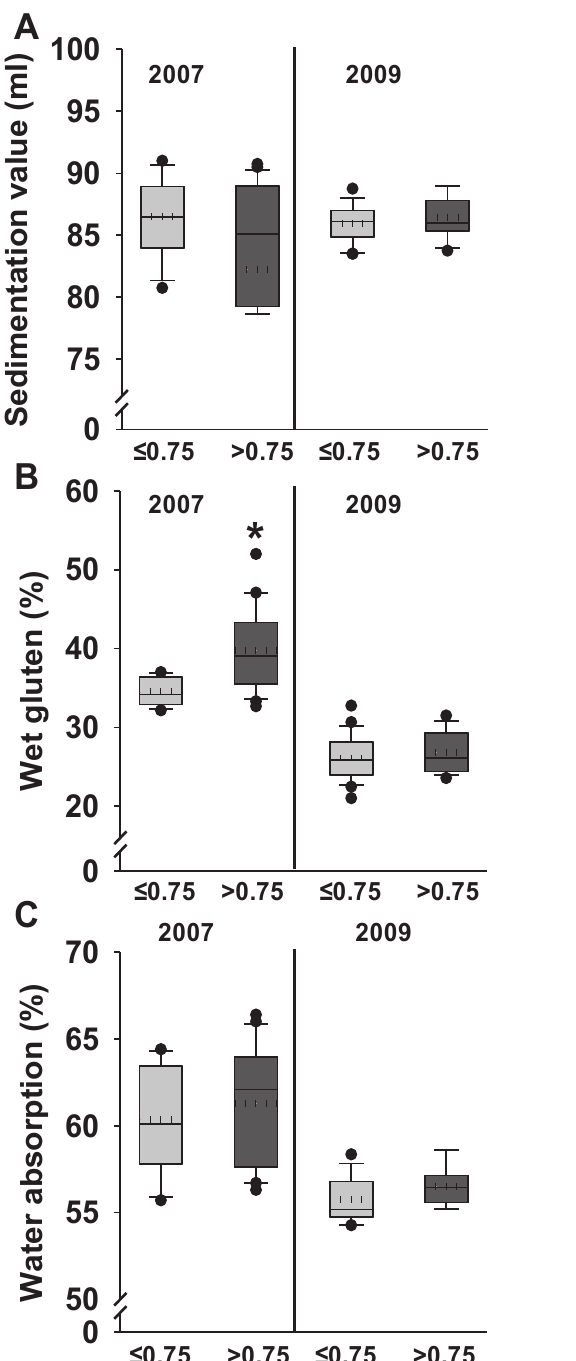
Fig. 5: Sedimentation value (A), wet gluten content (B), and water ab- sorption (C) of flour Type 550 samples in 2007 and 2009 grouped into fulfilling (≤0.75) and exceeding (>0.75) EU maximum level of DON (mg kg -1 ) in flour. Significant difference between groups within year is indicated through * (p<0.001). Box plots show 25- 75% percentile, median (solid line), and mean (dotted line).